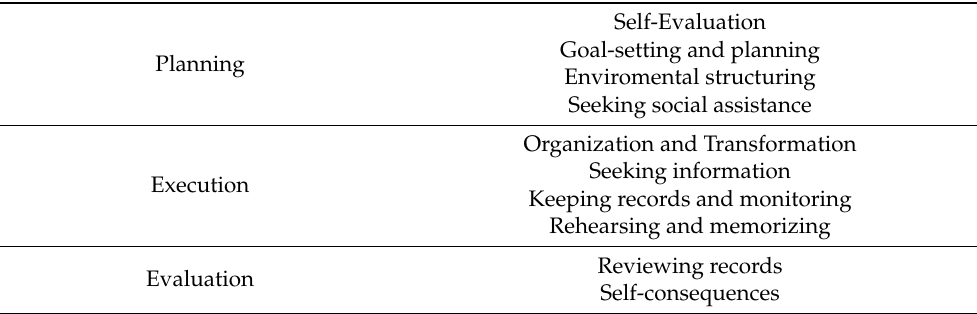
Table 1. SR learning strategies for each phase of the PLEE model (adapted from Zimmerman and Martinez-Pons (1986)